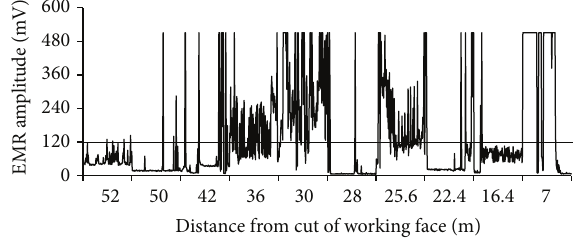
Figure 15: EMR amplitude variation in tailentry at the stage of third periodic caving. Note: the caving interval is 23 m, and the pressuring intensity is stronger based on in situ observation of roadway deformation and support resistance.